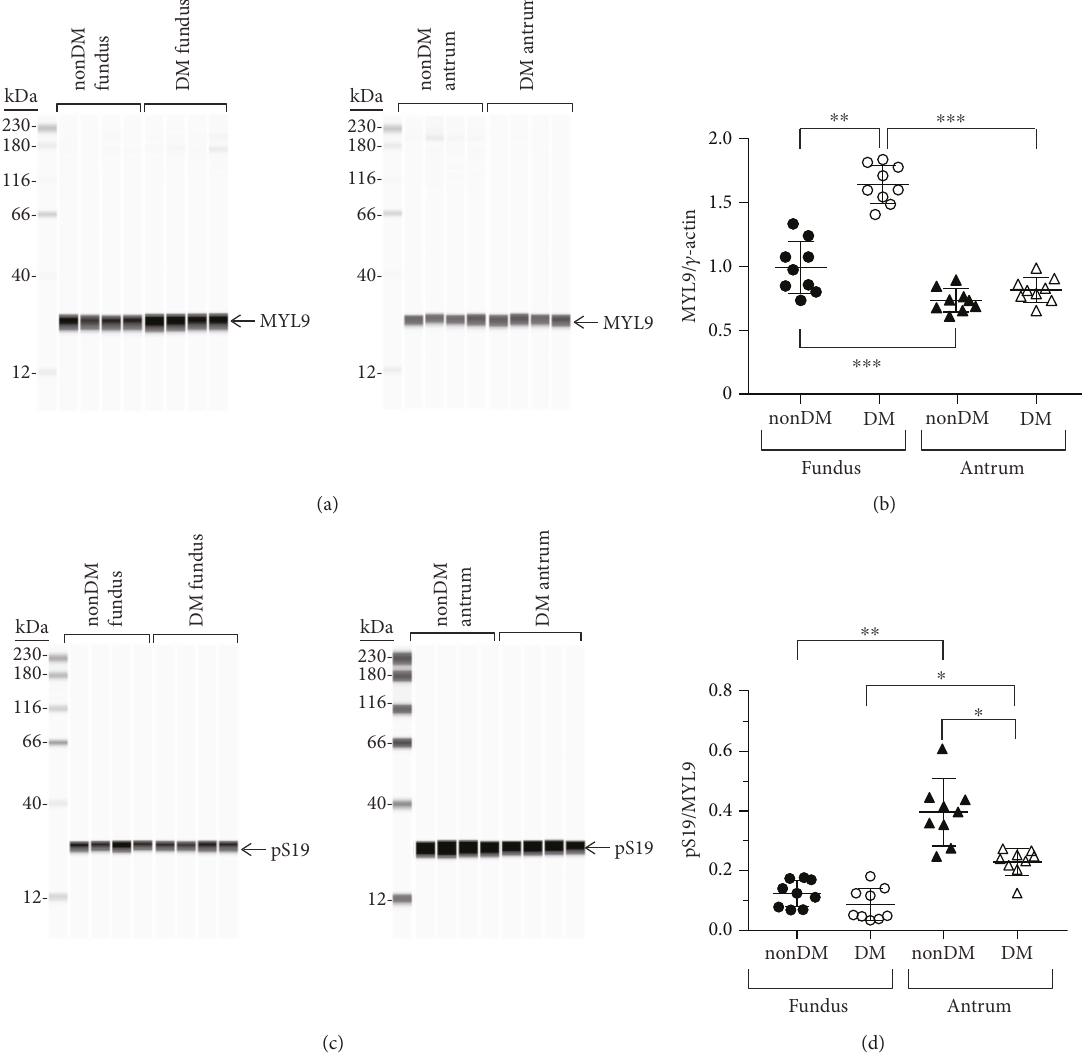
Figure 5: MYL9 expression and S19 phosphorylation in nondiabetic and diabetic gastric fundus and gastric antrum smooth muscles. (a) Representative immunoblots of MYL9 expression in nondiabetic and diabetic fundus (left panel, n = 4 , each group) and nondiabetic and diabetic antrum muscles (right panel, n = 4 , each group), 500 ng muscle lysate per lane. (b) MYL9 expression relative to enteric γ -actin expression in nondiabetic and diabetic fundus and antrum smooth muscles. (c) Representative immunoblots of phosphorylated S19 in nondiabetic and diabetic fundus (left panel, n = 4 , each group) and nondiabetic and diabetic antrum muscles (right panel, n = 4 , each group), 1 μ g muscle lysate per lane. (d) S19 phosphorylation relative to MYL9 expression in nondiabetic and diabetic fundus and antrum smooth muscles. ∗ P < 0 05 , ∗∗ P < 0 01 , and ∗∗∗ P < 0 0001 .